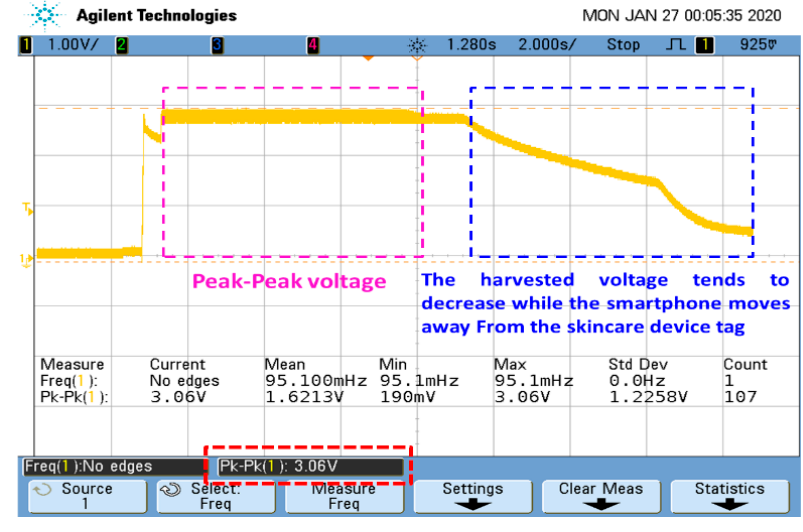
Figure 4. Maximum energy harvested from the NFC-enabled smartphone.